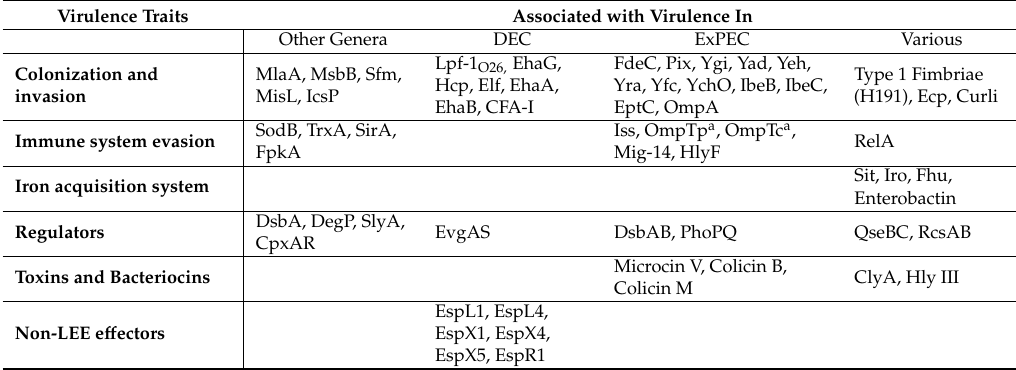
Table 2. Complete virulence factors